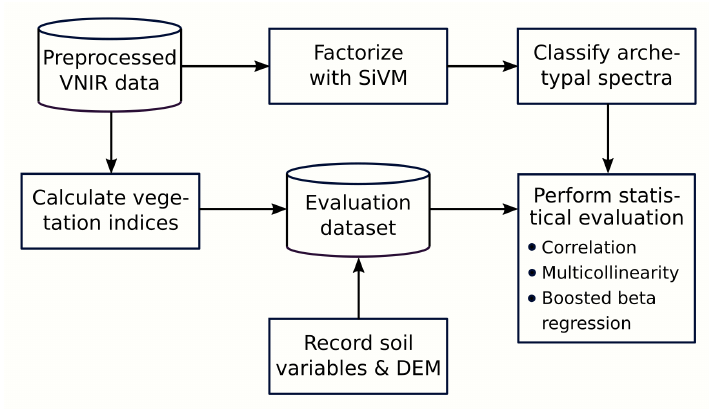
Figure 2. Overview of the main methodological